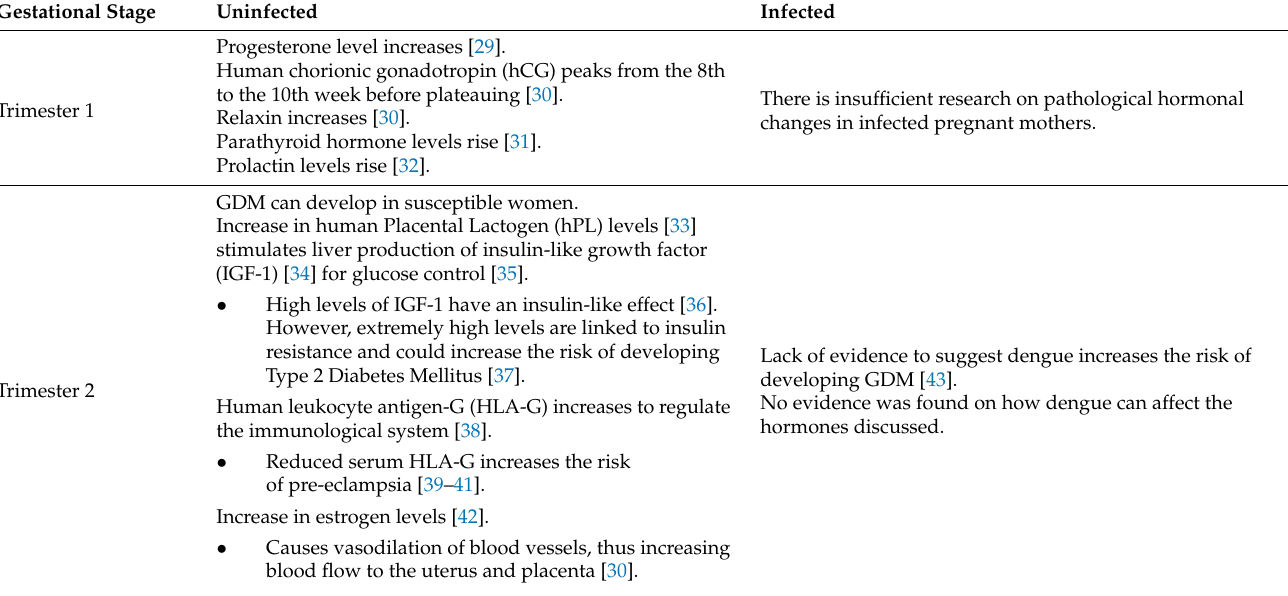
Table 2. Uninfected versus dengue-infected endocrinological changes in pregnant